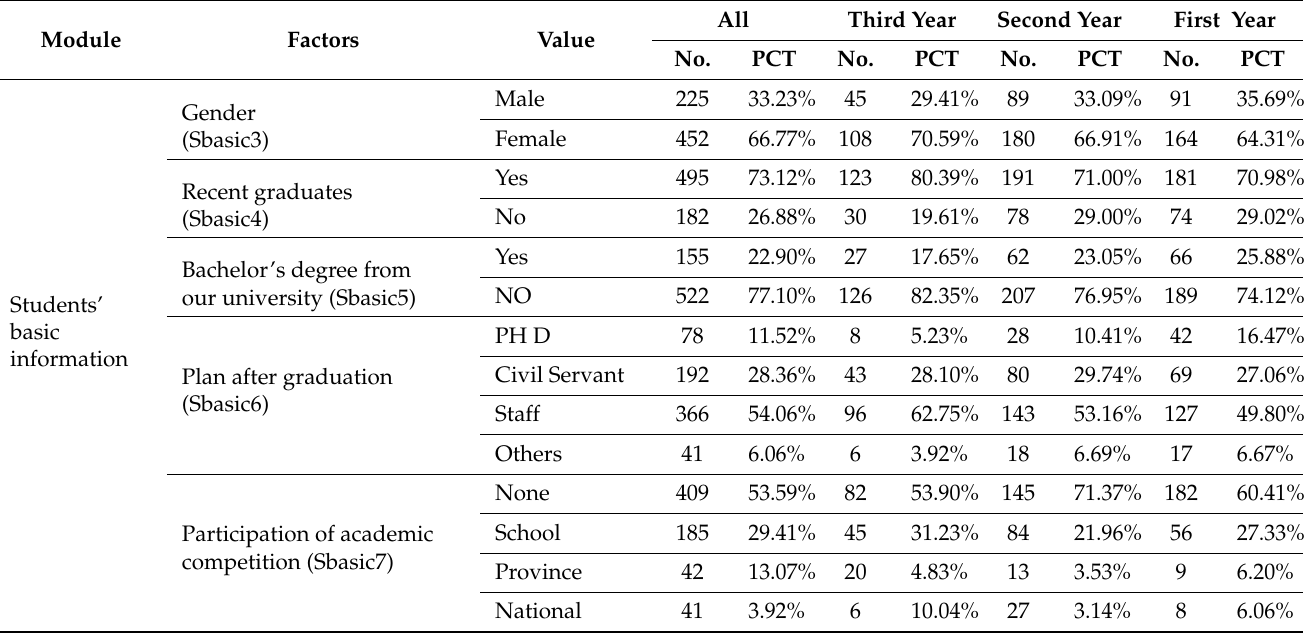
Table 1. The descriptive results of